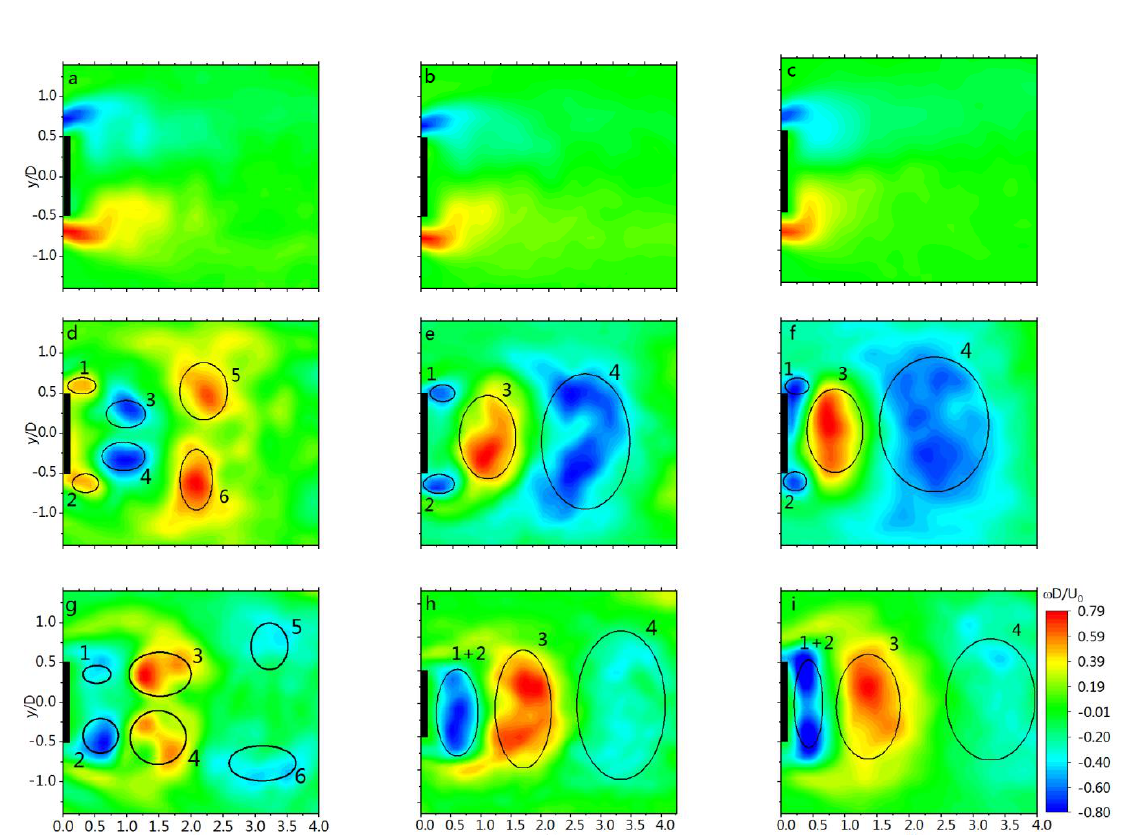
Figure 11. The modes of Proper Orthogonal Decomposition of Ar = 0.3: ( a ) Re = 1000, the zeroth-order mode (mean vorticity field); ( b ) Re = 2000, the zeroth-order mode (mean vorticity field); ( c ) Re = 5000, the zeroth-order mode (mean vorticity field); ( d ) Re = 1000, the first-order mode; ( e ) Re = 2000, the first-order mode; ( f ) Re = 5000, the first-order mode; ( g ) Re = 1000, the second-order mode; ( h ) Re = 2000, the second-order mode; ( i ) Re = 5000, the second-order mode.